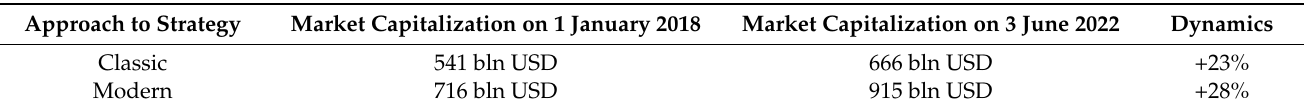
Table 14. The dynamics of an organization’s market capitalization in the context of approaches to